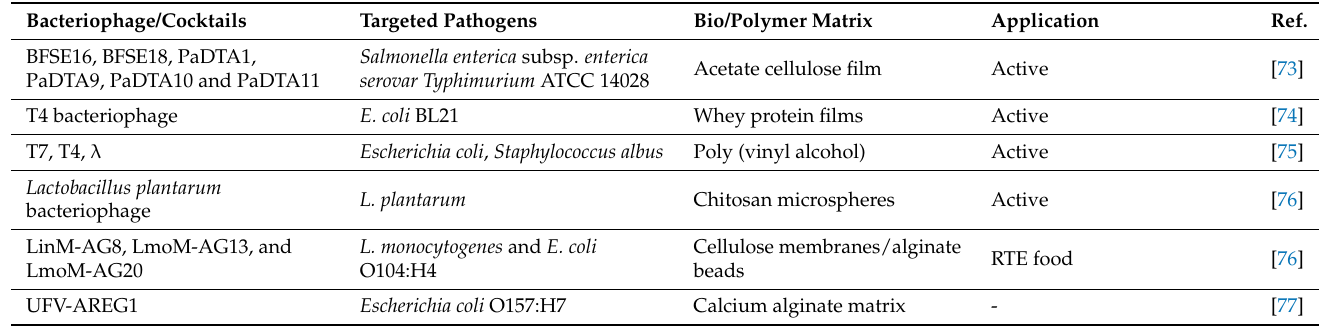
Table 1. Various reports on bacteriophage-based biopolymeric active packaging